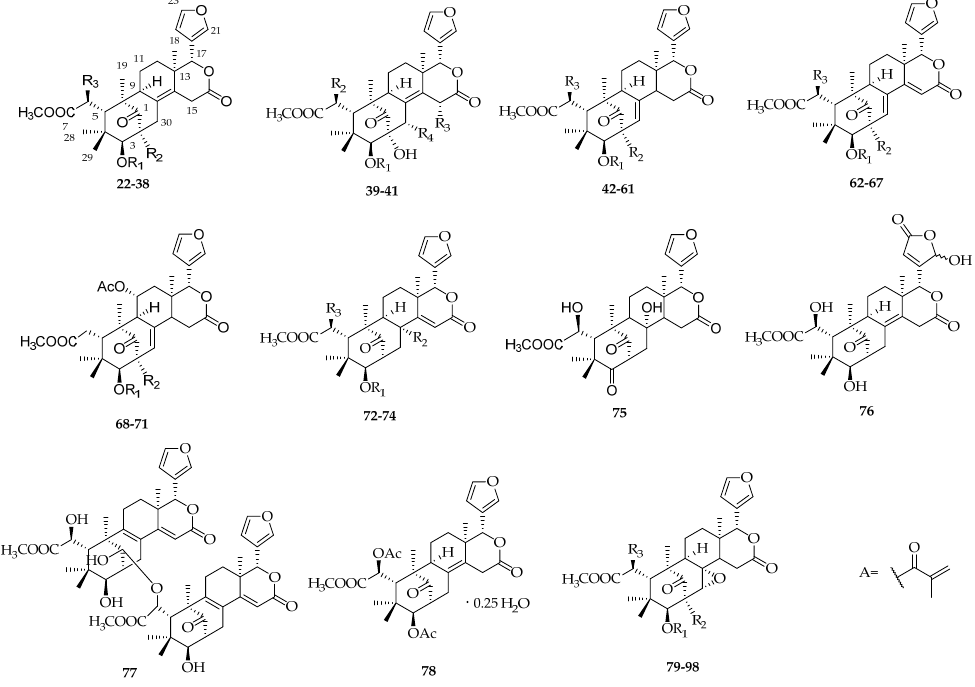
Figure 4. Chemical structures of mexicanolide ‐ type limonoids 22 – 98 . Table 3. Structures and sources of mexicanolide ‐ type limonoids 22 – 98.